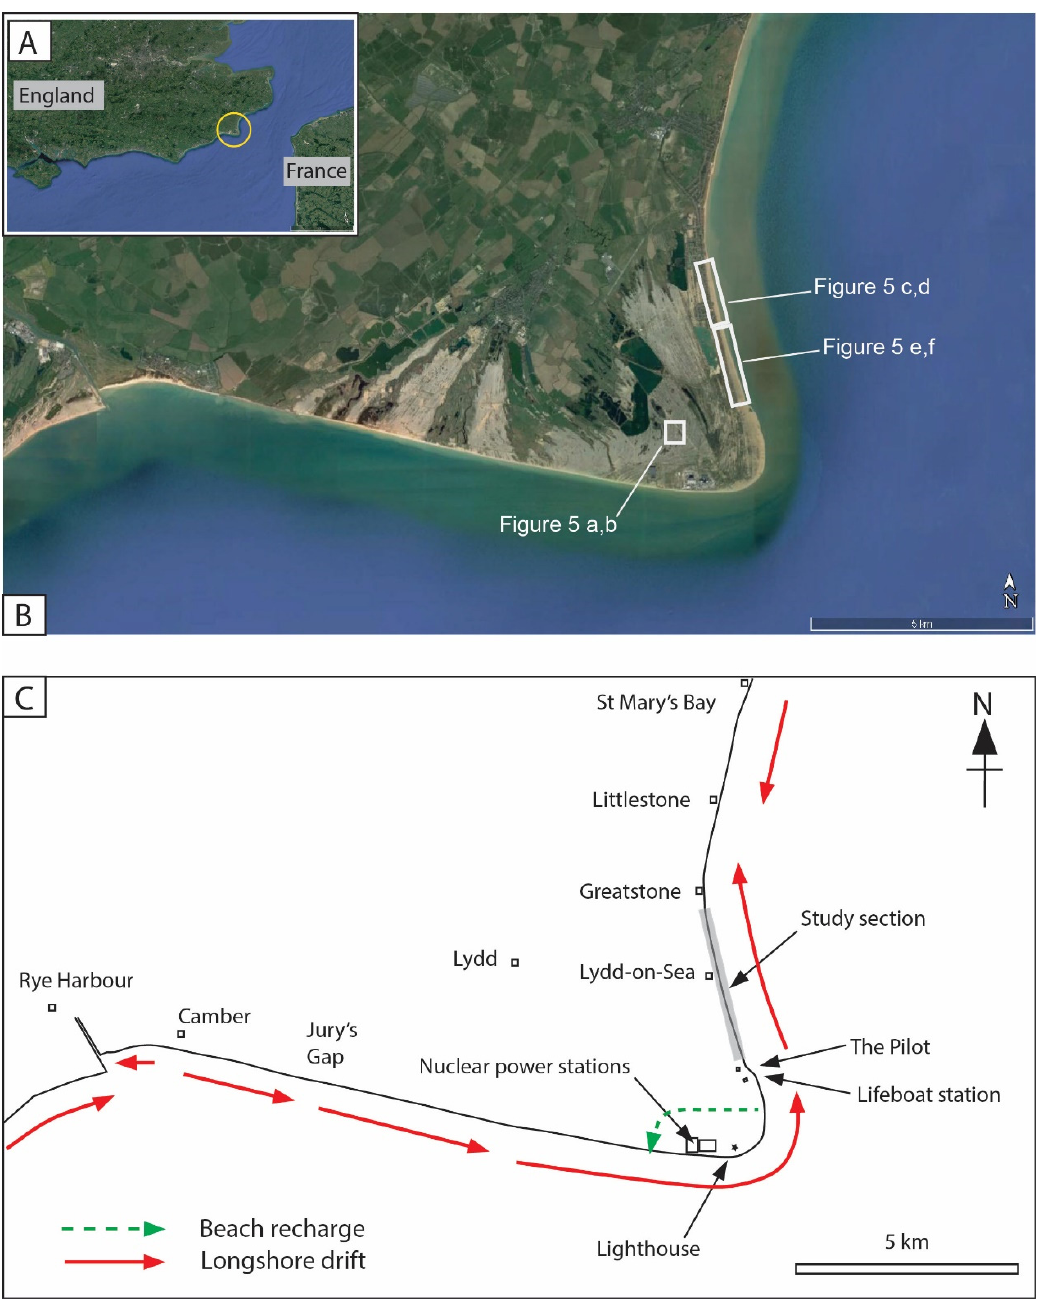
Figure 1. ( A ) Dungeness location on the south coast of England. ( B ) Google Earth™ satellite image of Dungeness; the light toned areas are shingle with little vegetation, inset boxes show locations of Figure 5a–f. ( C ) Annotated map showing the shape of the cuspate foreland, locations described in this paper, and the directions of longshore drift (red arrows) from [4]. The study section shown in detail in Figure 3 is depicted by gray tone.